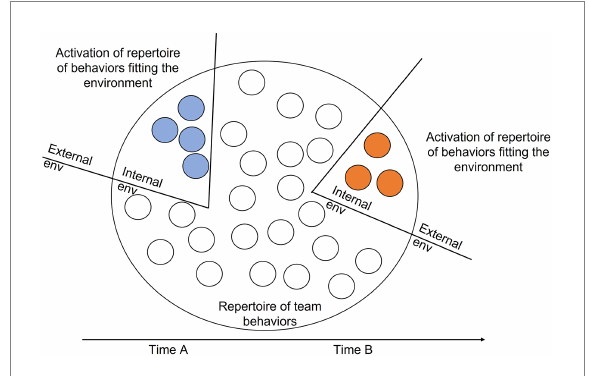
FIGURE 1 How a team’s behavioral repertoire aligns with its environment.